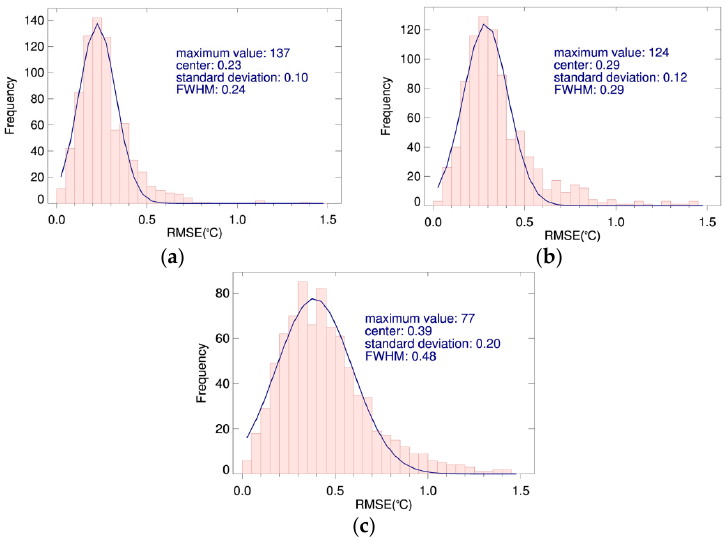
Figure 5. Histograms of root mean square errors in 0.05 °C bin width for ( a ) drifter measured SST; ( b ) NAVO S-NPP VIIRS SST and ( c ) AQUA MODIS SST, corresponding to Figure 4. The fitting of the Gaussian function to the RMSE is the blue line, the maximum value, center, standard deviation, and full-width-half-maximum (FWHM) of the Gaussian function are output on the plot as well. Ideally, the distribution of random error should be normal. The Gaussian fitting shows normal in the range of 0–0.5 °C, 0–0.6 °C, and 0–0.8 °C for drifter measured SST, NAVO S-NPP